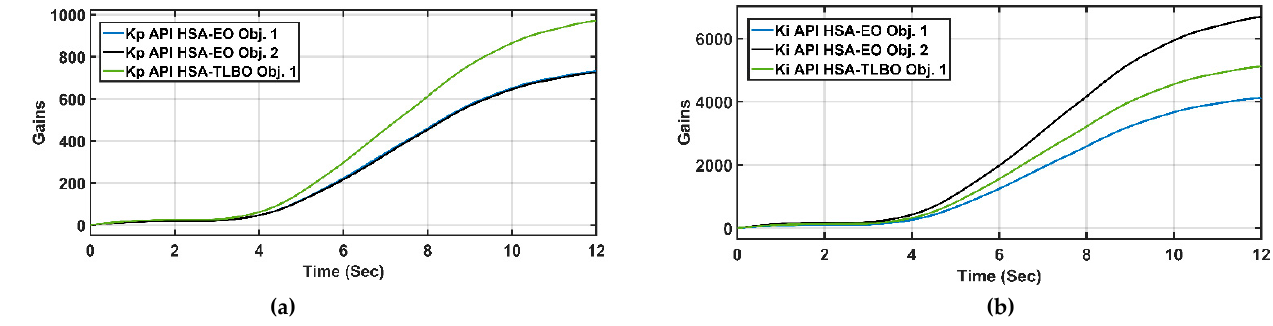
Figure 23. Blade angle of the controllers at normal fourth case.